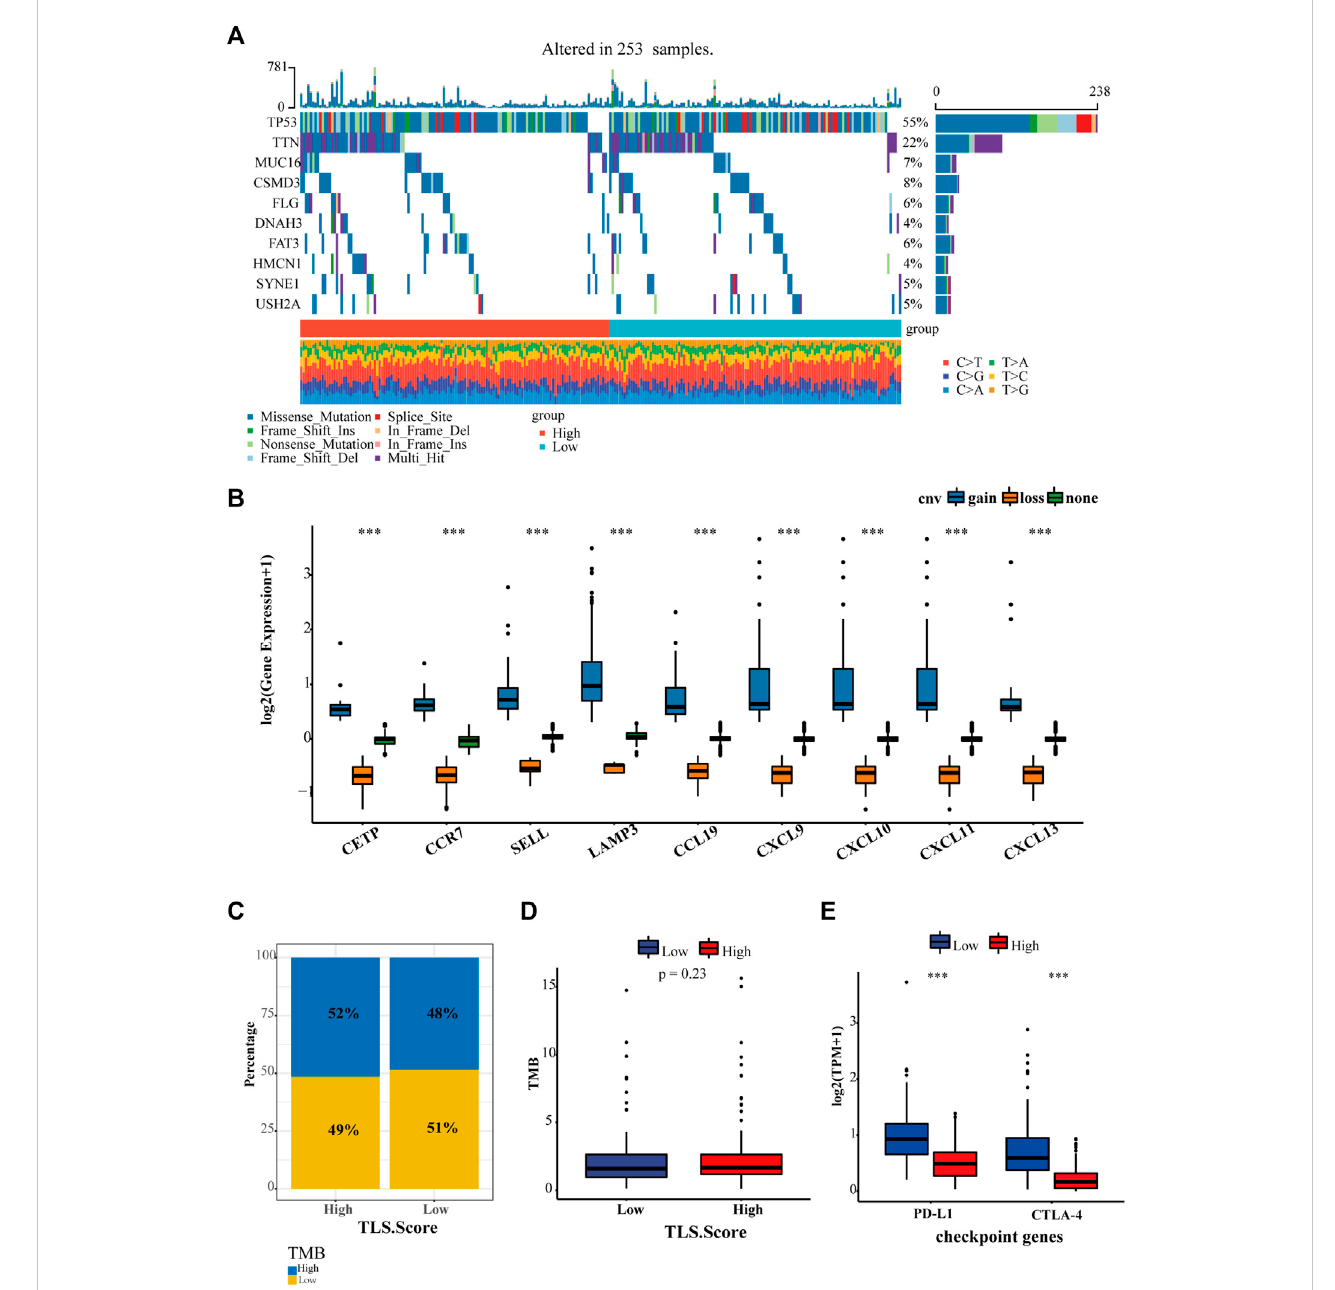
FIGURE 6 TherelationshipbetweenTLSgenesignatureandexistingmarkersofimmunotherapy. (A) ThelandscapeofgeneticvariationoftheTLSgenesignaturein the OV cohort. (B) The CNV variation frequency of the TLS gene signature in the OV cohort. The proportion (C) and frequency (D) of tumor mutation load between high and low TLS gene signature groups. (E) The distinction of PD-L1 and CTLA-4 between high and low TLS gene signature groups. ( p p < .05, pp p < .01, and ppp p <